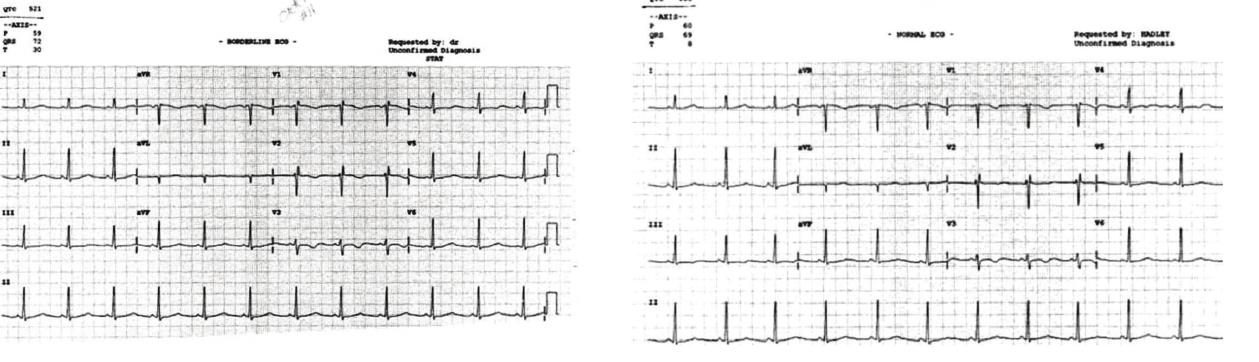
Figure 3: Electrocardiogram obtained 2 weeks after hospital dis- charge. Note the improved QT interval (465ms) while on treatment for congenital QT